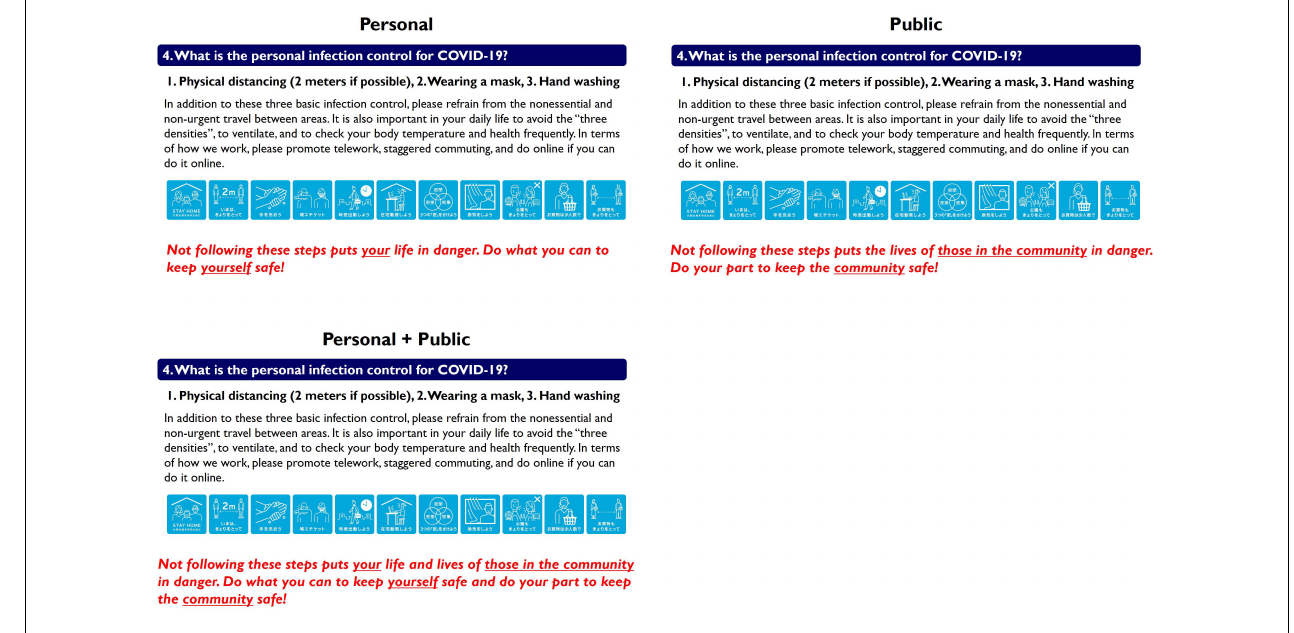
FIGURE 1 | Messages shown in each